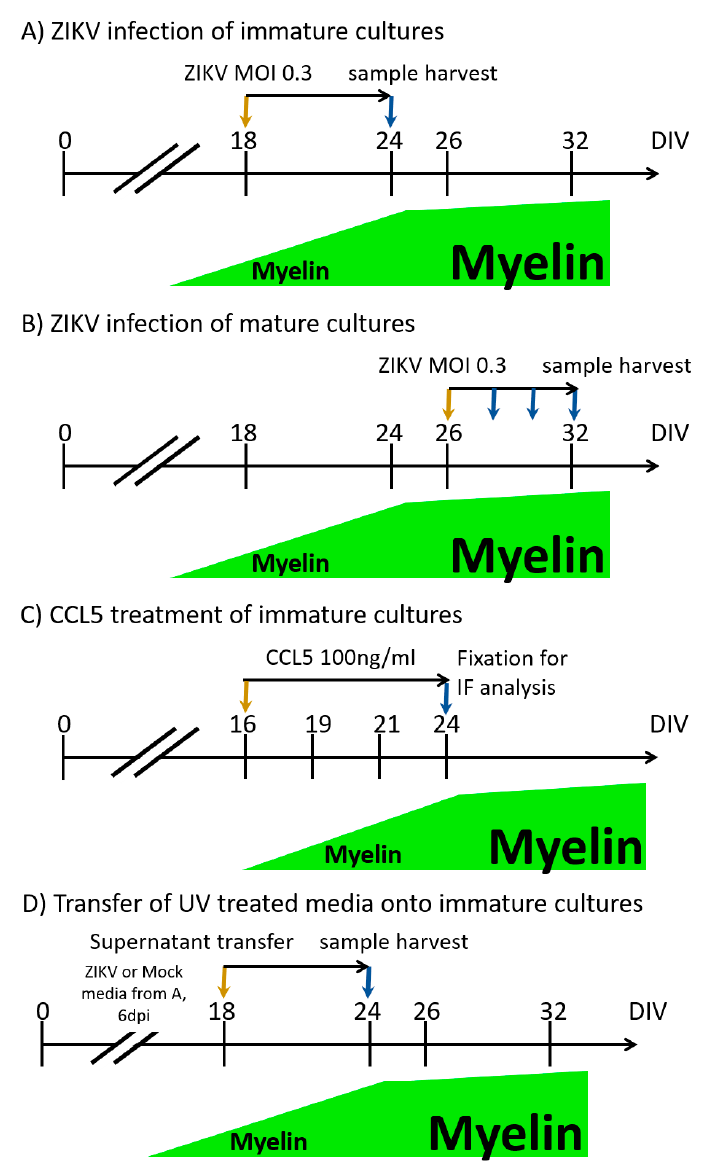
Figure 1. Schematic of central nervous system (CNS) cultures infected with Zika virus (ZIKV) or treated with CCL5. Orange arrows indicate the start of infection or treatment, while blue arrows indicate the day of sampling for either analysis by immunofluorescence (IF) or RNA isolation. To establish how the ZIKV infection of immature mouse CNS cultures ( A ) compares to ZIKV infection of mature CNS mouse cultures ( B ) with regard to infection and pathology, cultures were infected with ZIKV at an multiplicity of infection (MOI) of 0.3 or mock-infected (referred to as Mock in figures) and analyzed by IF after 6 dpi using our previously established protocols [44]. Cultures were always matched, so immature and mature cultures were derived from the same pool of spinal cord cells (embryonic spinal cords of one dam, taken at E13). To assess the progress of infection in mature mouse CNS cultures ( B ) and transcriptome changes, cultures were infected in the same manner, and samples were harvested at 2 and 4 dpi. ( C ) CCL5 treatment of rat CNS cultures was carried out from day in vitro (DIV) 16 until DIV 24. Cultures were fixed and analyzed by IF. ( D ) To determine whether soluble factors contributed to the observed pathology in ZIKV-infected cultures, the supernatant of ZIKV infected cultures was harvested at 6 days post-infection (dpi) (from cultures as described under ( A )) and UV-inactivated. Then, supernatant (diluted 3:1 with fresh medium) was transferred onto immature CNS cultures, and cells were fixed 6 days post-transfer